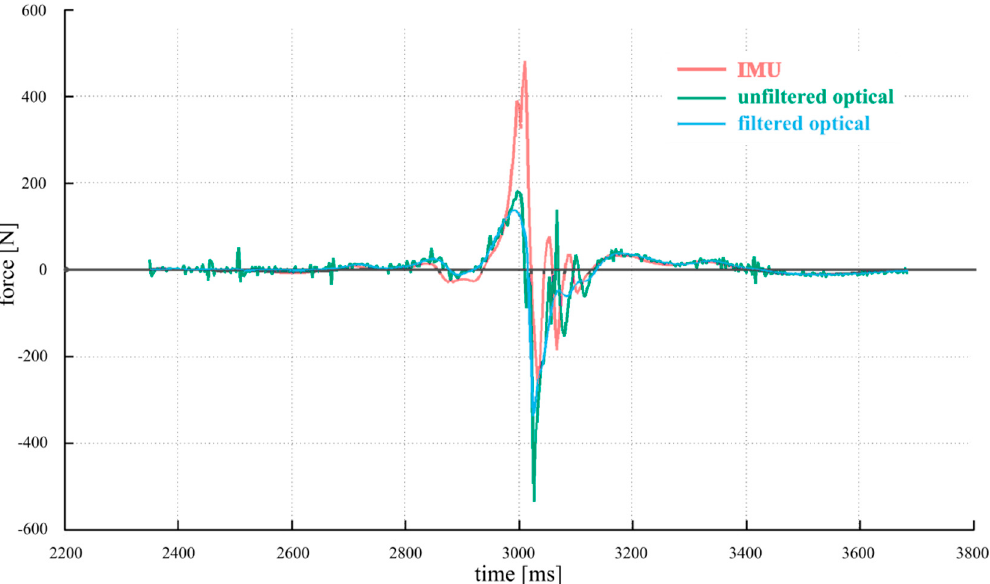
Figure 5. Sagittal plane X axis (throwing direction) wrist joint force for a typical fastball pitch: IMU, filtered and unfiltered optical data.